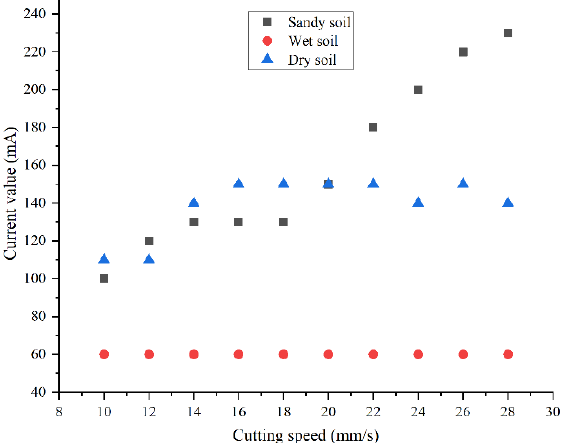
Figure 16. The determination experiment of cuttage speed.